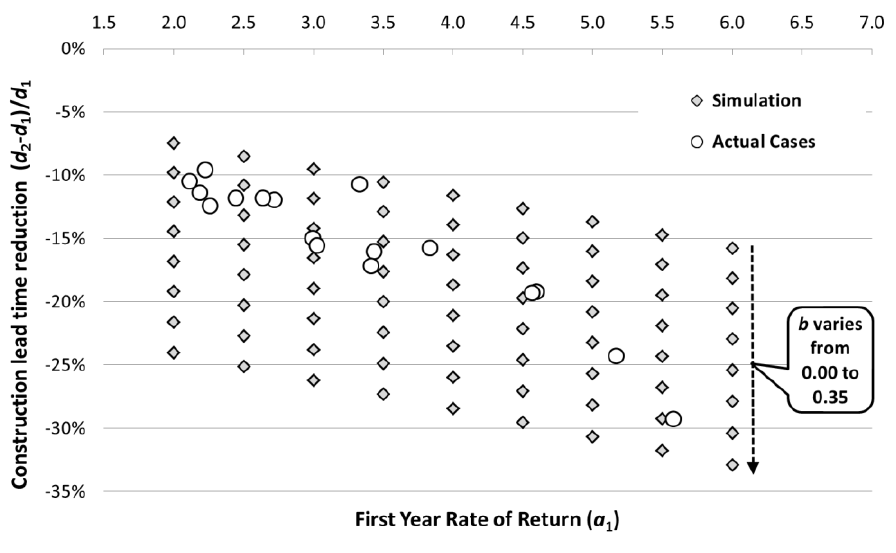
Figure 8. Gain in efficiency on construction lead time d 2